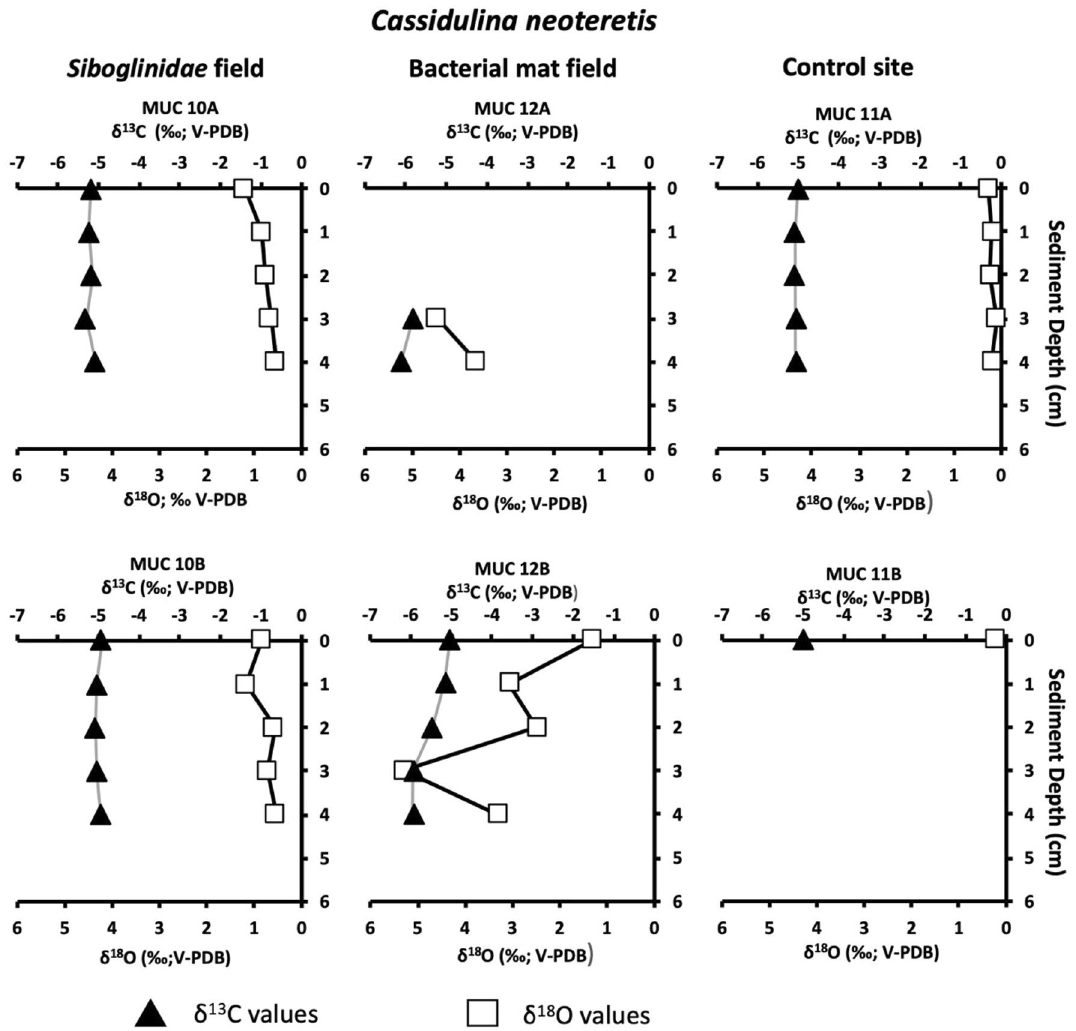
Figure 7. Oxygen isotope values (δ 18 O) of empty tests of Cassidulina neoteretis in sediment from the Siboglinidae field (MUC 10A and MUC 10B), bacterial mat field (MUC 12A and MUC 12B), and control site (MUC 11A and MUC